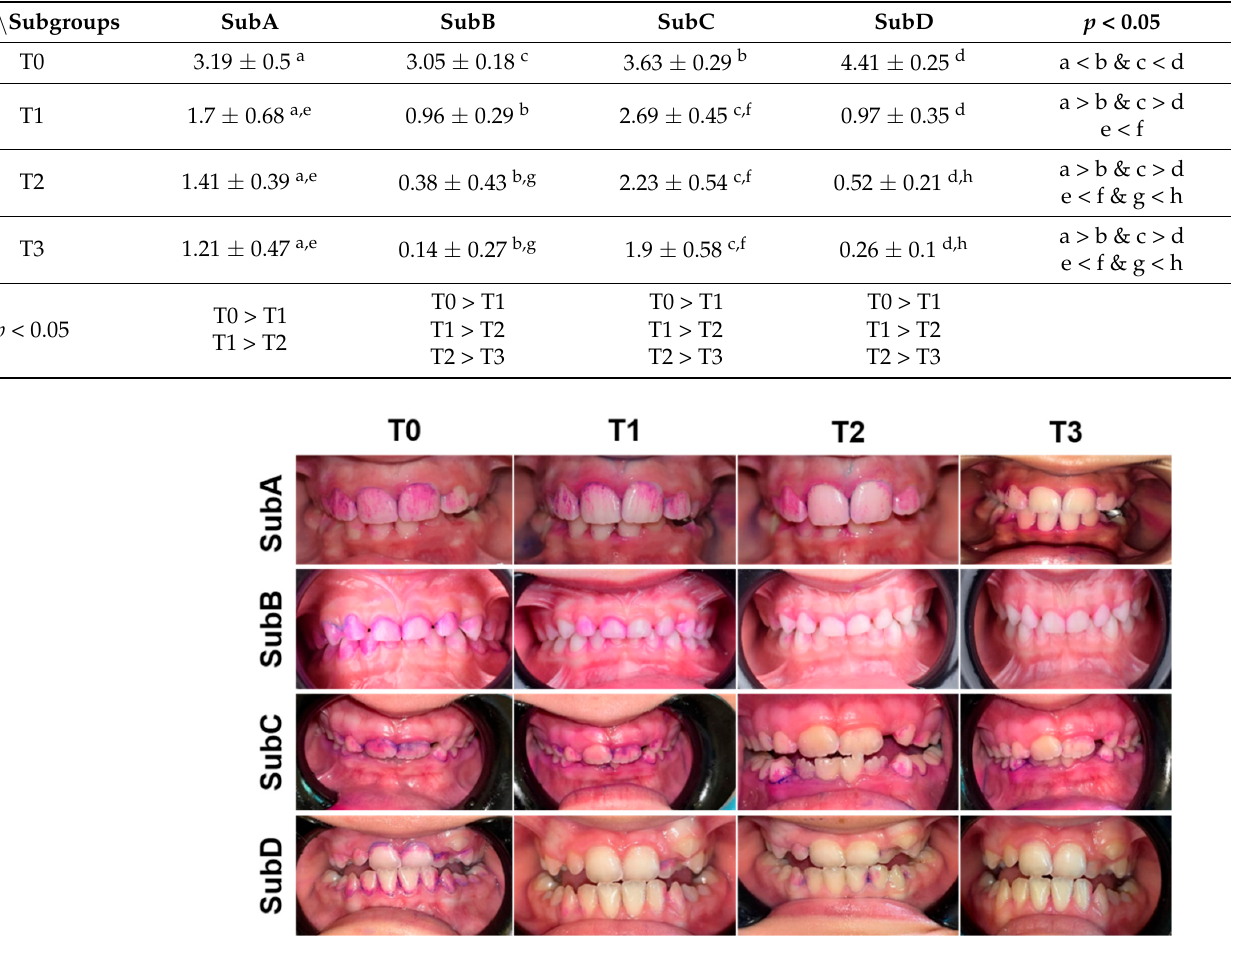
Figure 3. Assessment of (TMQHPI) for conventional/customized handle toothbrush in children with post-brushing at baseline (T1), 1 week (T2) and 3 weeks (T3)). Table 4. Mean and standard deviations for each score of gum status for the (MGI) at the different periods for SubA: Children with no special needs who used a conventional toothbrush; SubB: Children with no special needs who used a customized handle toothbrush; SubC: Children with Down syndrome who used a conventional toothbrush; SubD: Children with Down syndrome who used a customized handle toothbrush. Upper letters ( a–h ) indicate statistically significant differences (raw) between the different subgroups ( p <